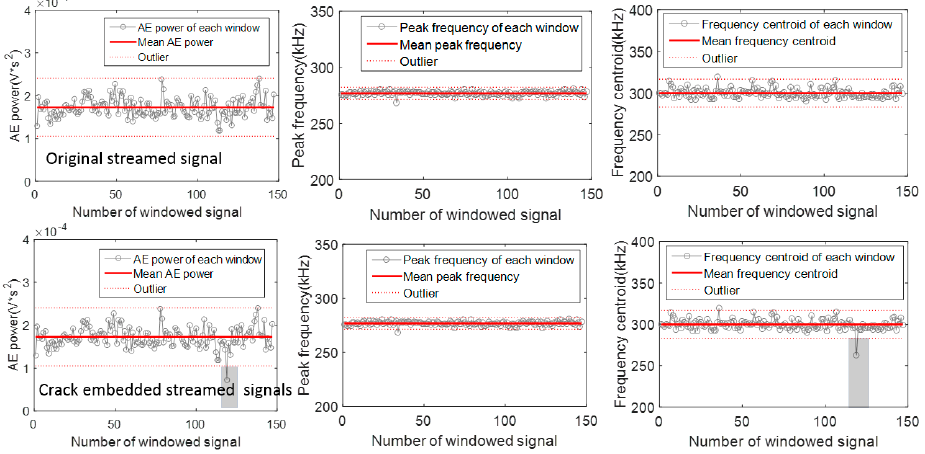
Figure 11. The outlier detection of AE power, peak frequency and frequency centroid of original streamed signal and embedded streamed signal ( SNR = 1.0, location of cracking signal: 120).